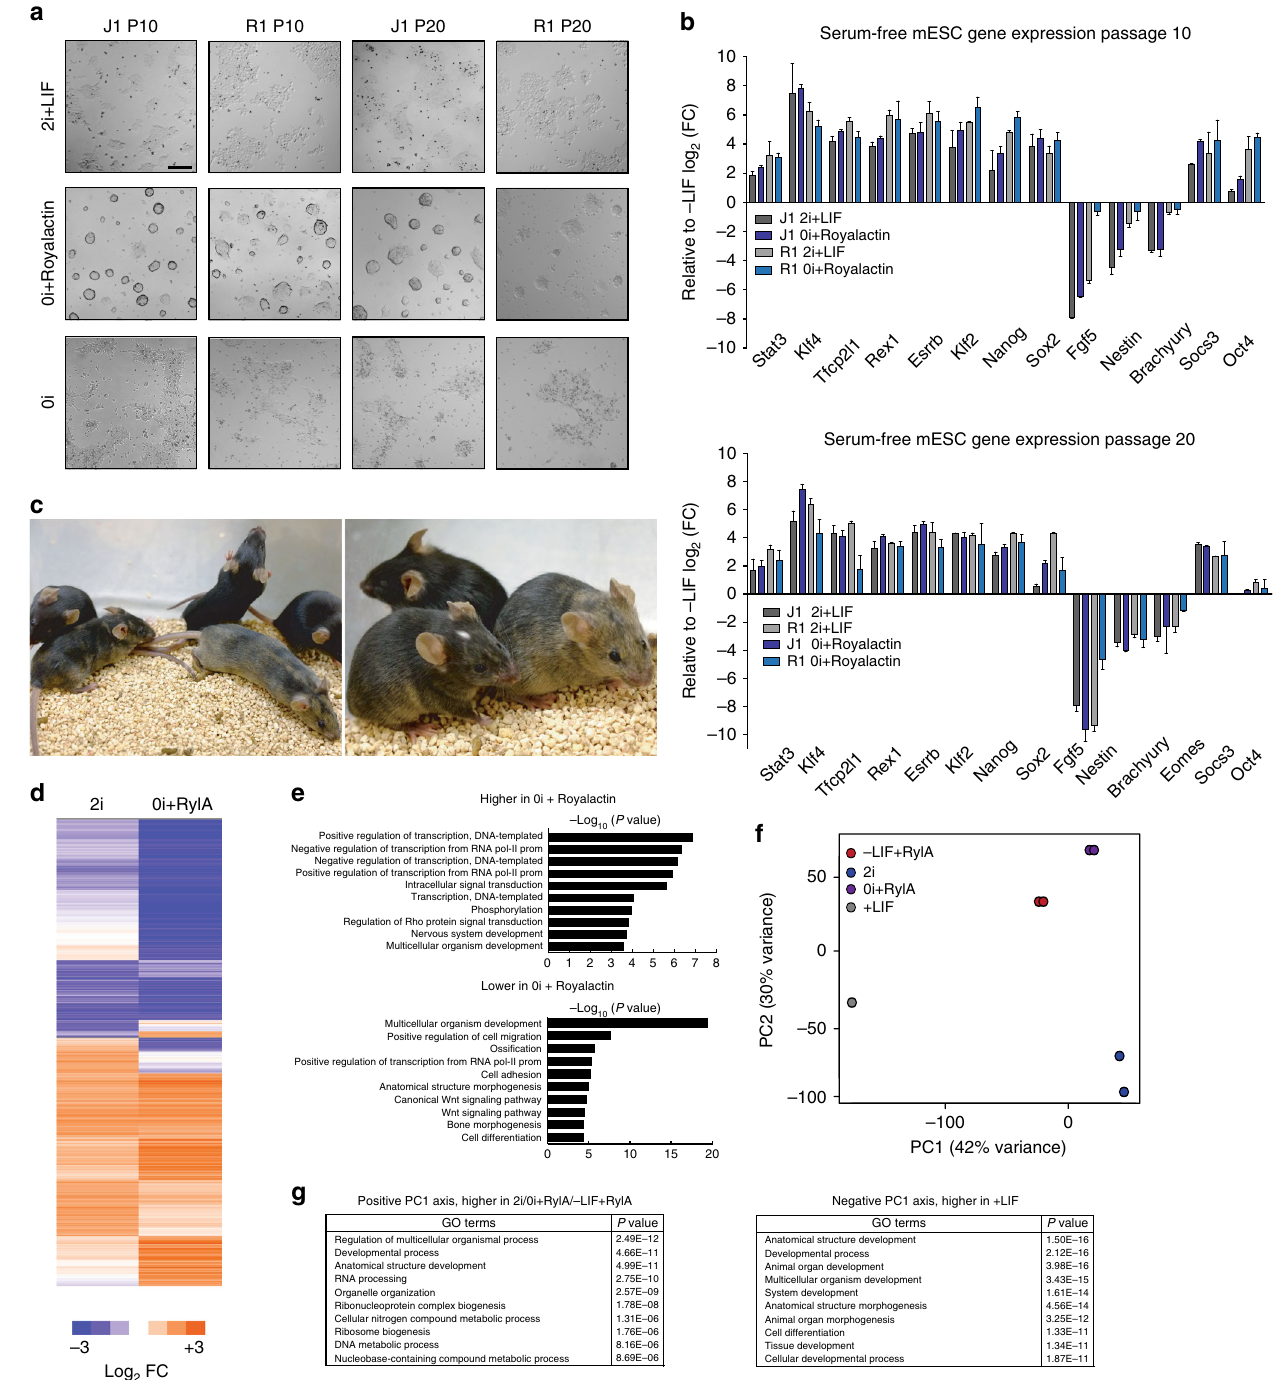
Fig. 2 Royalactin drives a ground-state-like pluripotency state in mESCs. a Representative images of J1 and R1 mESCs cultured in serum-free media in the presence (2i + LIF) or absence (0i) of MAPKKi, GSK3i, and LIF for 10 and 20 passages. mESCs rapidly differentiated in 0i, whereas cells cultured with Royalactin (0i + Royalactin) supported self-renewal with negligible differentiation. Scale bar, 200 μ m. b Quantitative expression of pluripotency and differentiation-associated genes from a . Data are means ± SD ( n = 2). c Chimeras with germline transmission formed by CGR 8.8 mESCs treated for ten passages with 0i + Royalactin. d RNA-seq log 2 fold change values in transcript level of all genes in 2i or 0i + Royalactin (0i + RylA) J1 mESCs (passage 10) relative to 0i. e GO term analysis of the differentially expressed genes from d . f J1 mESCs cultured in serum/ + LIF, serum/ − LIF + Royalactin, 2i + LIF, and 0i + Royalactin for ten passages are projected onto the fi rst two principal components. All genes with mean normalized read counts larger than 10 were considered for principal component analysis (PCA). g Distribution of genes contributing to principal component 1 (PC1) in f , and GO enrichment analysis of genes most strongly contributing to PC1 separation. RylA